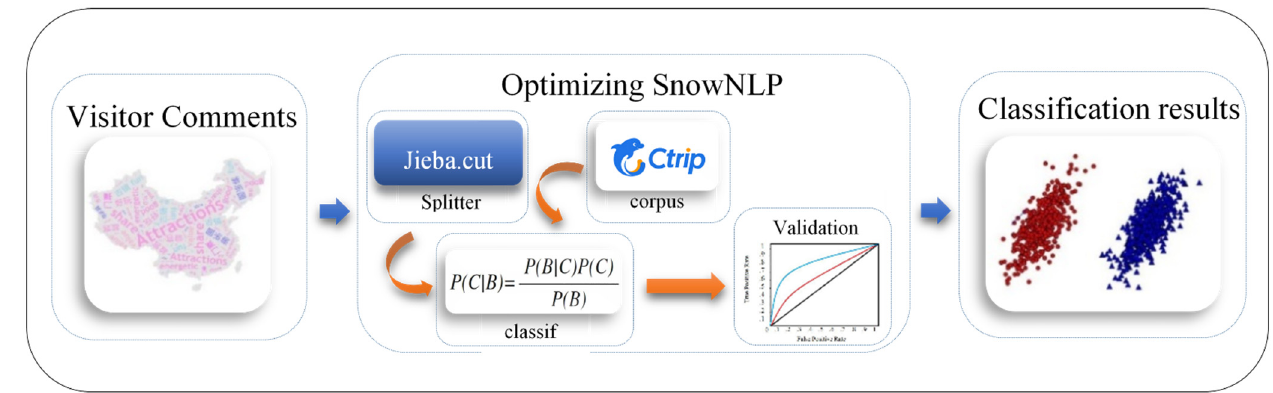
Figure 3. Sentiment classification